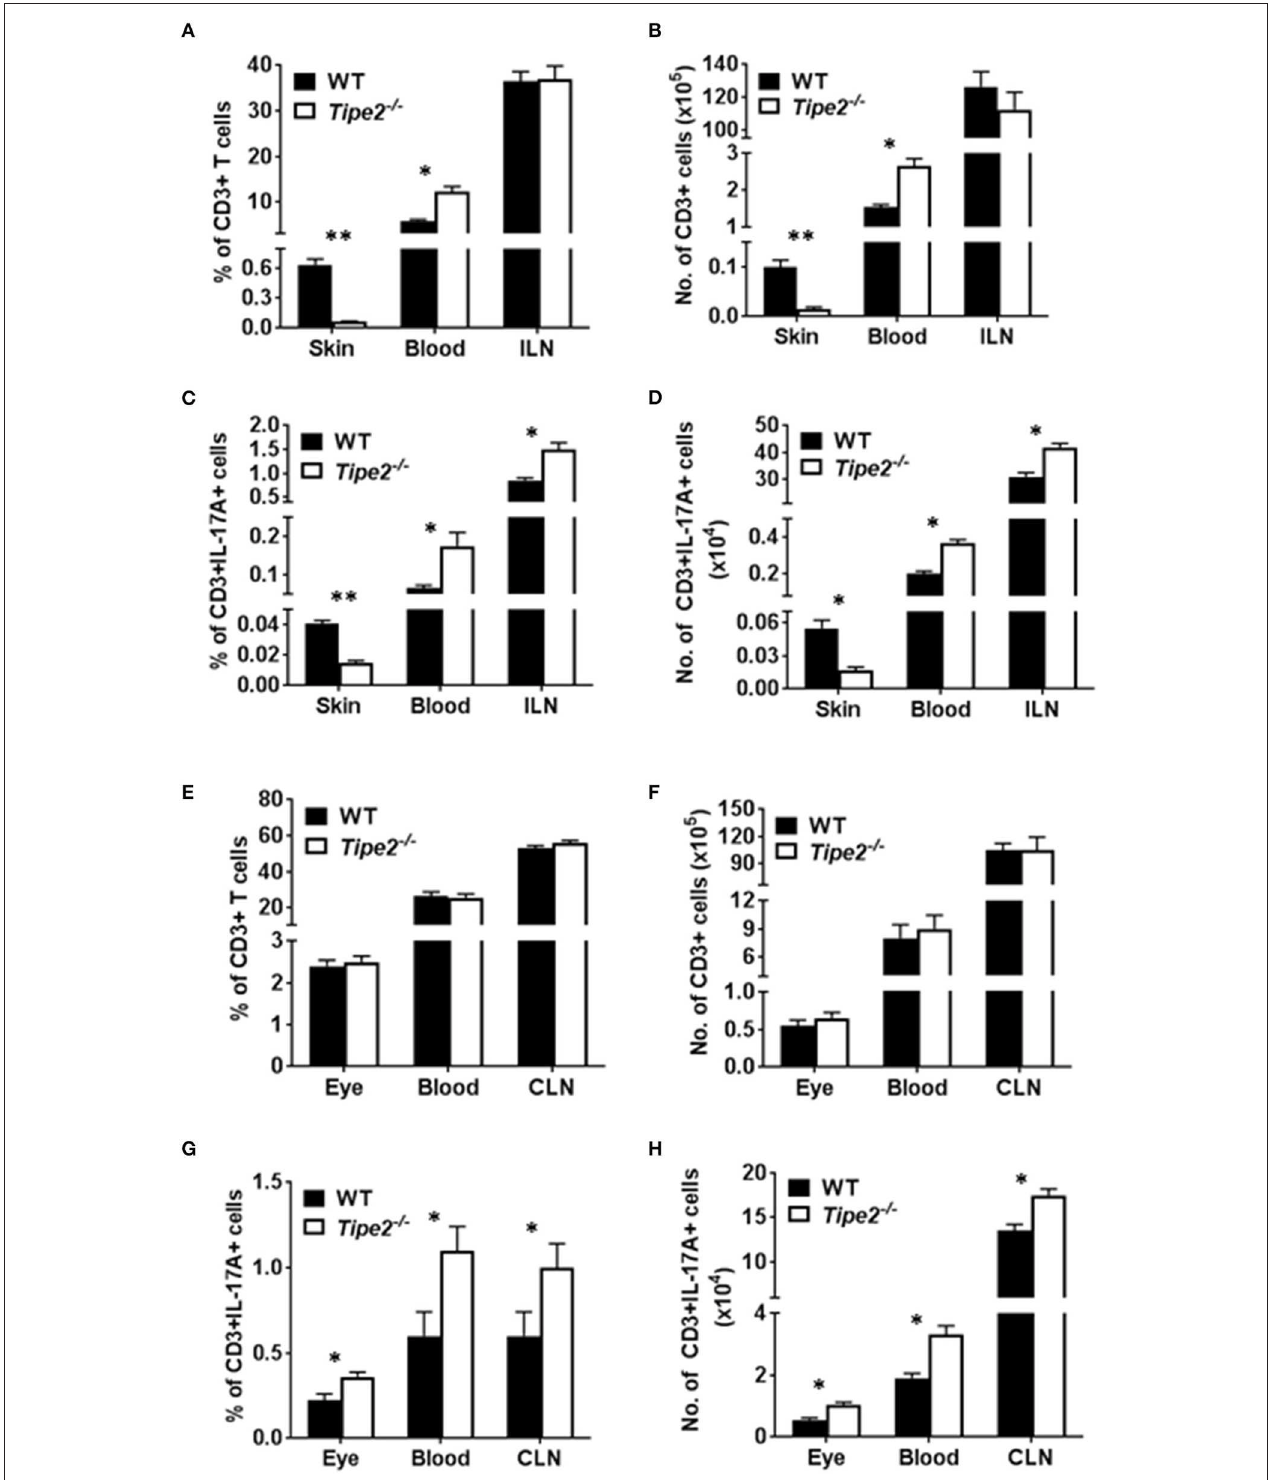
FIGURE 4 | Comparison of the percentage and absolute number of CD3 + and CD3 + IL-17A + T cells in WT and TIPE2-deficient mice. (A–D) WT ( n = 5) and TIPE2-deficient ( n = 5) mice were treated as in Figure 1A and killed 3 days after the first IMQ treatment. The percentage (A) and absolute number (B) of CD3 + T cells in the skin (0.8 cm 2 ), blood (0.6ml) and ILN were determined by cell surface staining with fluorescent labeled antibody against CD3. The percentage (C) and number